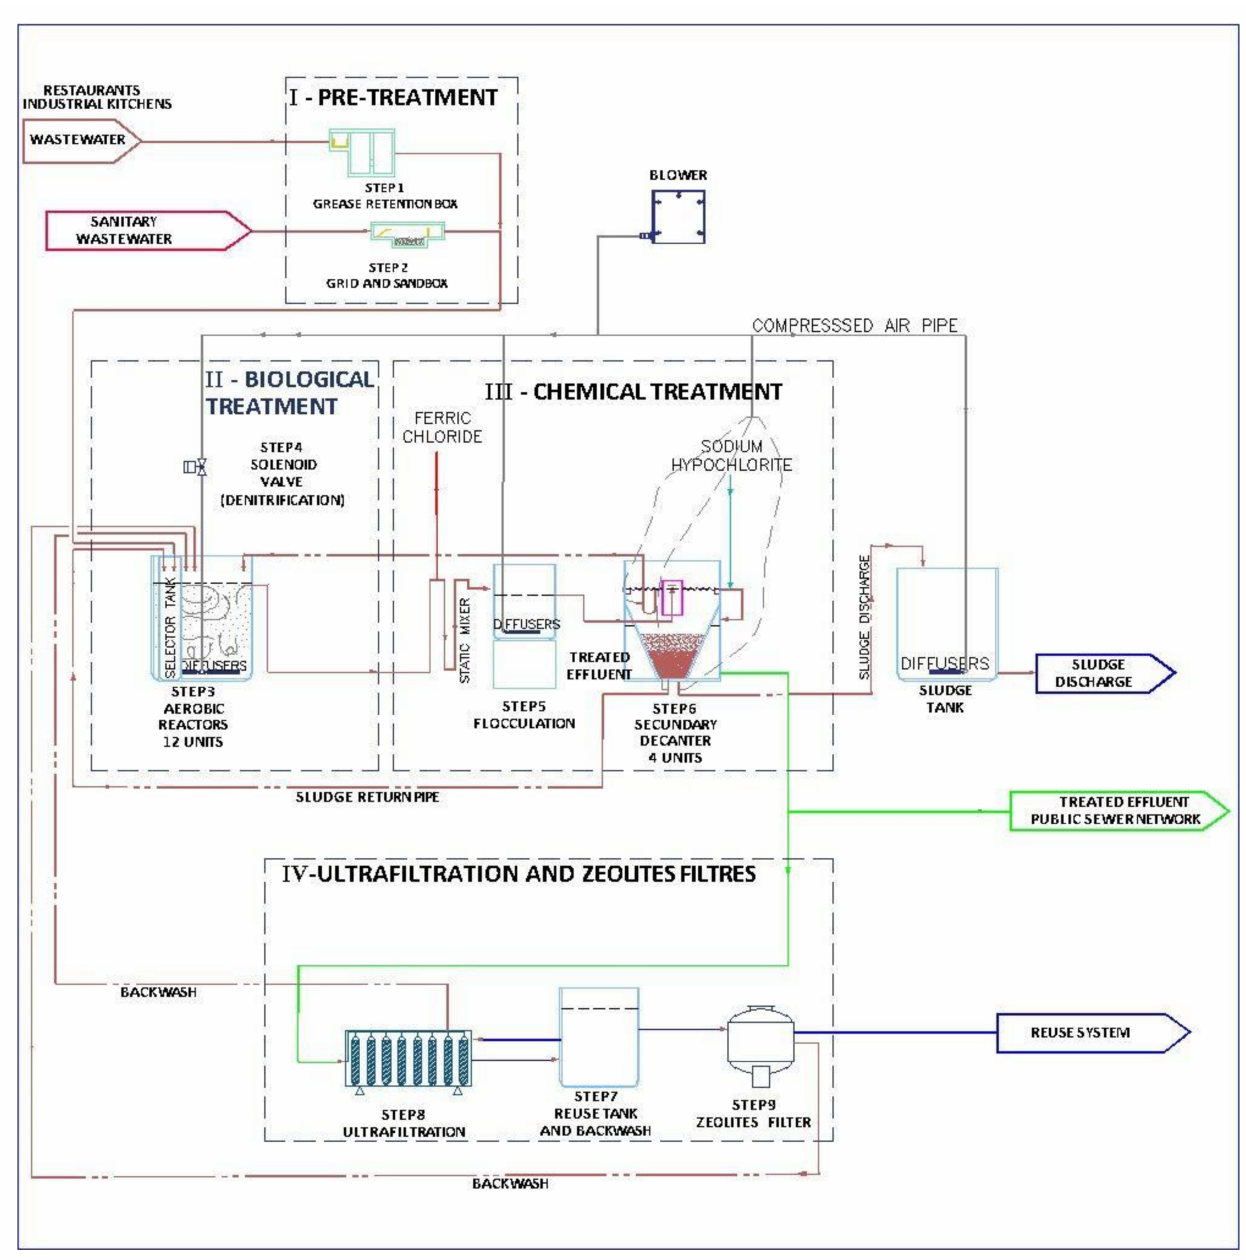
Figure 1. The WWTP with nine steps: 1-grid and sandbox for solid residues reduction; 2-oil and grease retention box to reduce the effect of these fats on the development of the microbial community; 3-aerobic reactors for carbonaceous organic matter degradation; 4-denitrification of organic matter and releasing of N 2 ; 5-flocculation of residual salts; 6-decanting for removing the sludge from the treated water, 7-disinfection to remove pathogens; 8-ultrafiltration; 9-filtration by zeolites for retention of colloidal